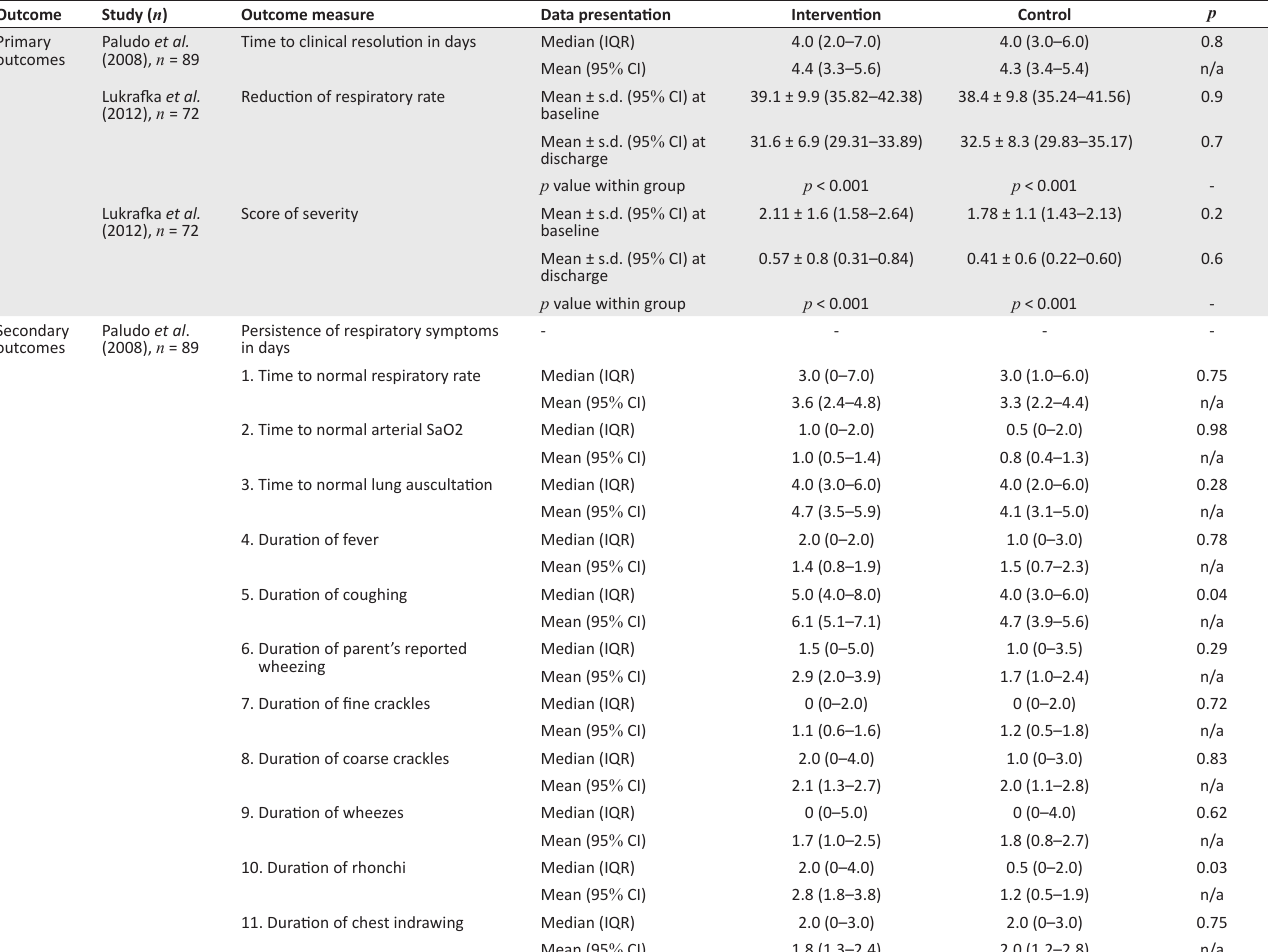
TABLE 4: Other outcome measures.